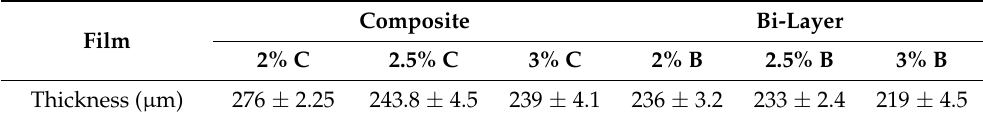
Table 2. Measurement of thickness films.